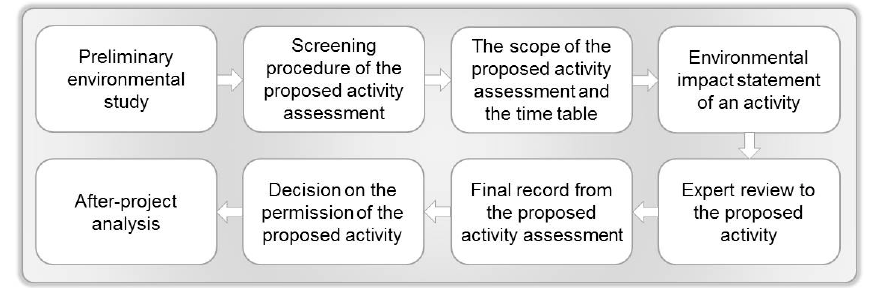
Figure 1. Main steps of the Environmental Impact Assessments (EIA) process in Slovakia (National Council of the Slovak Republic 2005) [22].